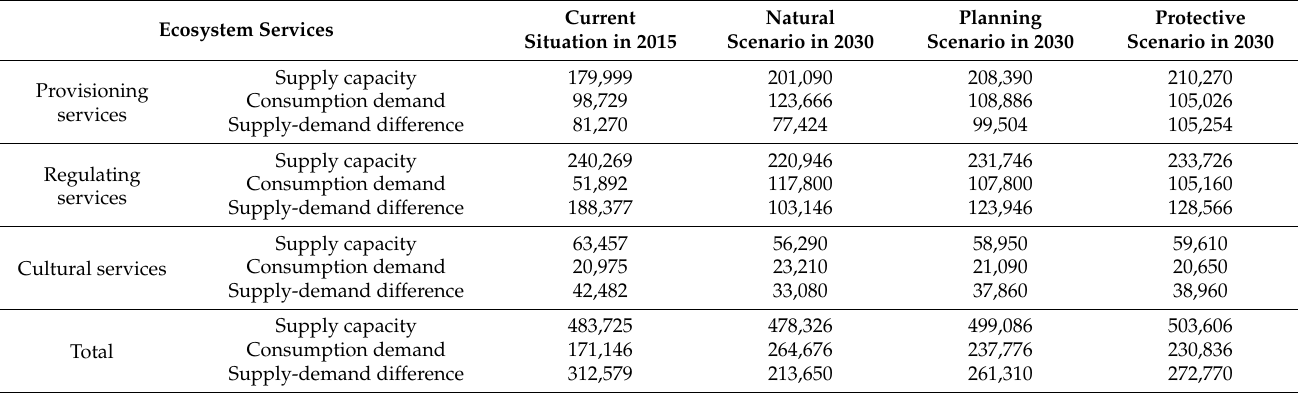
Table 8. Contrast of ecosystem services supply and demand in 2030 under different scenarios